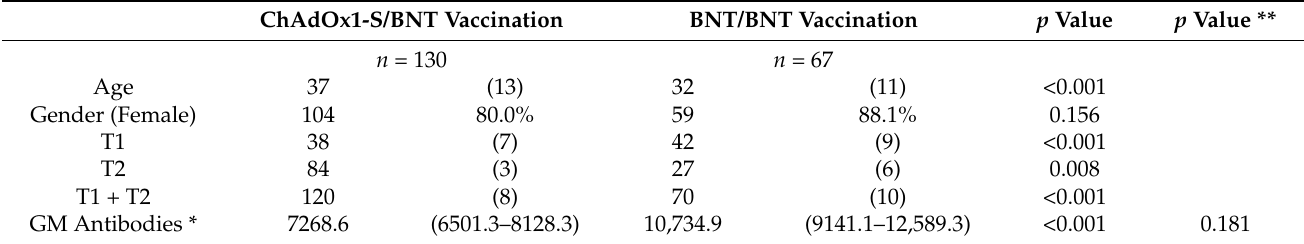
Table 1. Characteristics of the study population.